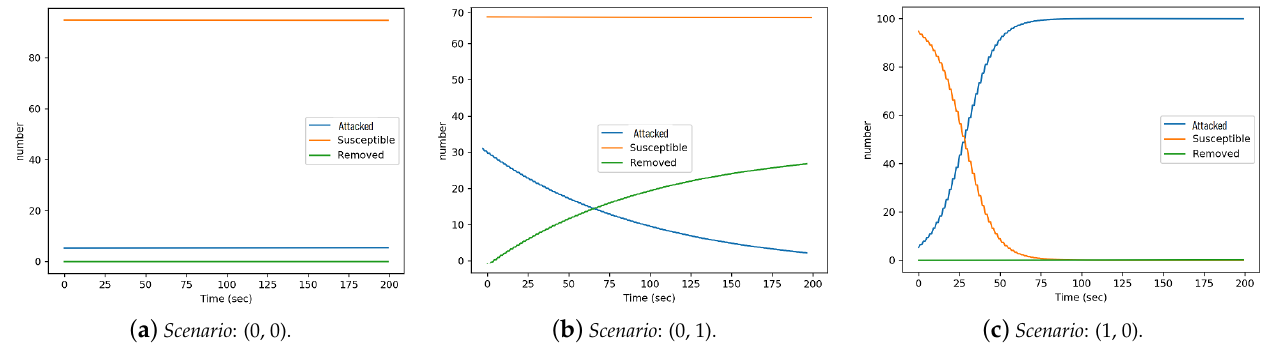
Figure 8. Outbound actuation scenarios: ( s − 2 − a , a − 2 − r